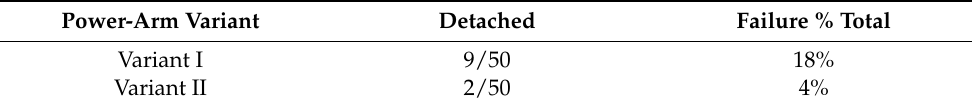
Table 4. Clinical evaluation of power-arm resiliency according to debonding